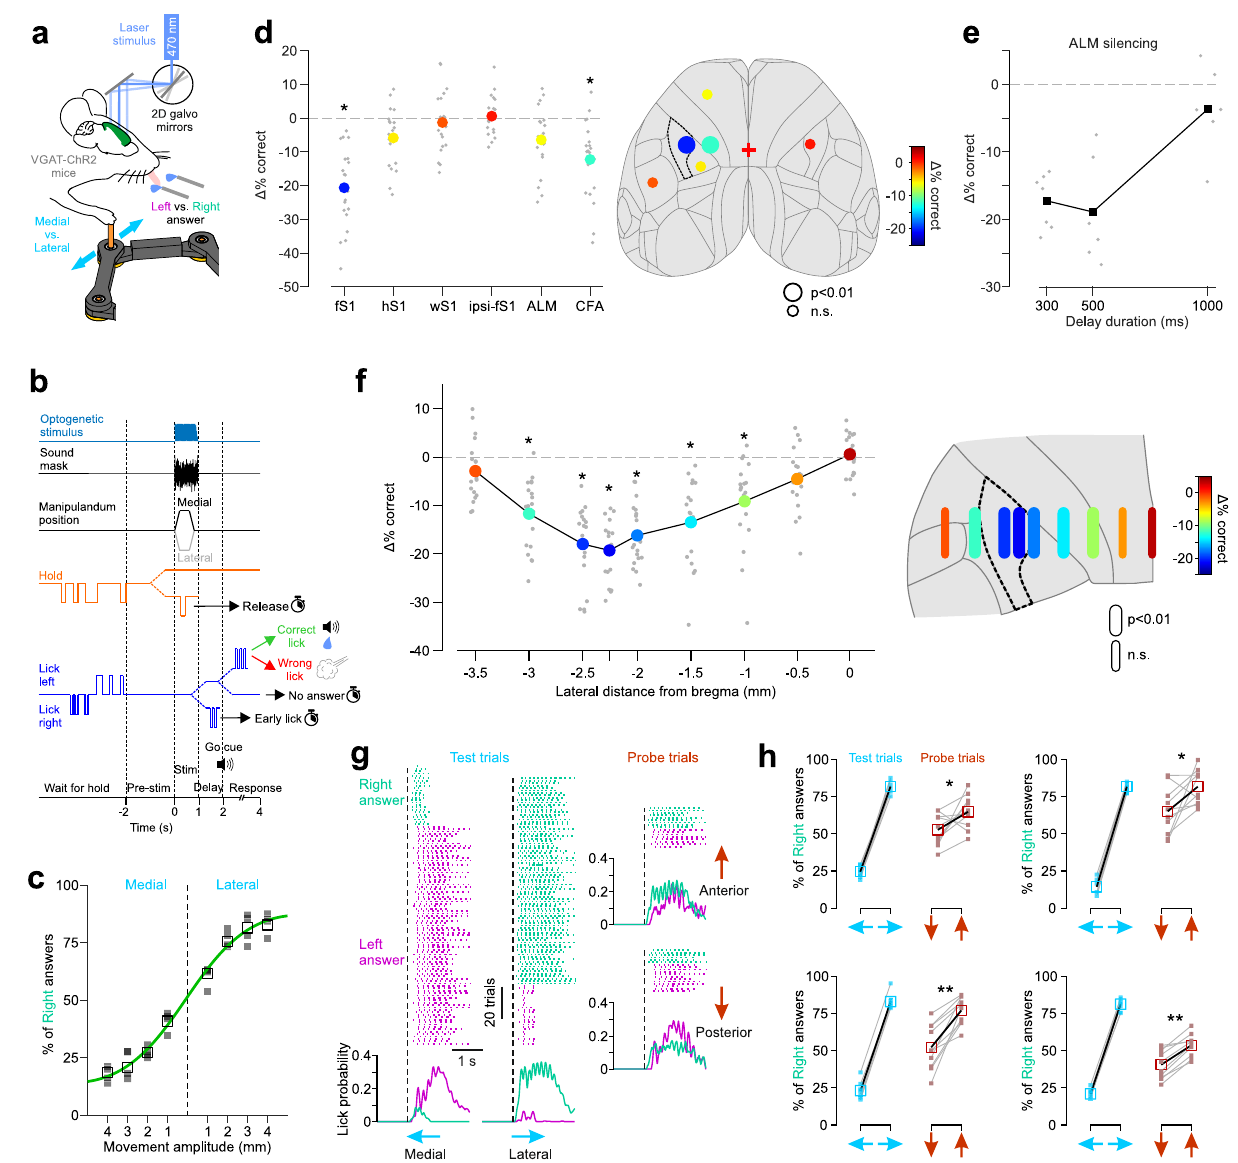
Fig. 3 | Identi fi cation of behavioral variables and cortical areas necessary for perceptual discrimination of forelimb proprioception. a Schematic of the optogenetic silencing experiment during a 2AFC proprioceptive discrimination task. b Trial timeline (split dotted lines denote different trial outcomes). c Psychometric discrimination curve fi tted to the mean (empty squares, minimum 200 trials/amplitude) answer % ( N =4 mice, fi lled squares). d Left, mean (colored circles, N =4 mice) decrease in performance (difference in % of correct trials compared to no stimulation) during selective optogenetic silencing (single point stimulation) of different cortical areas. Gray circles are data from individual ses- sions (5 sessions per mouse per area). fS1: forelimb S1, hS1: hindlimb S1, wS1: whisker S1, ipsi-fS1: ipsilateral fS1, ALM: anterior lateral motor area, CFA: caudal forelimb motor area. *: p <0.01 (two-sided t-test, Bonferroni corrected). Right, same data depicted on the top projection of the Allen Mouse Brain Atlas (fS1 is highlighted by dotted lines). e decrease in performanceduring ALM silencing with